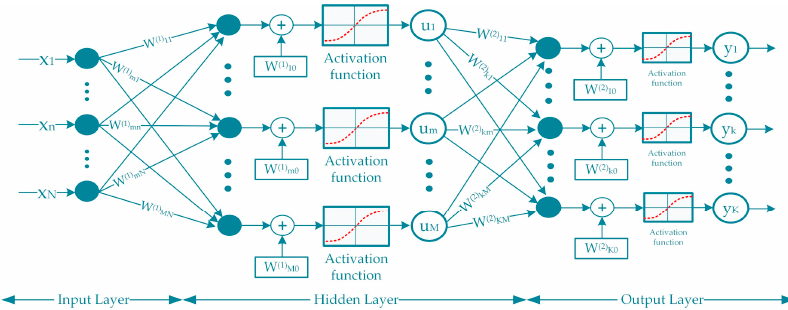
Figure 3. Structure of the feedforward MLP network (two-layer in this example).